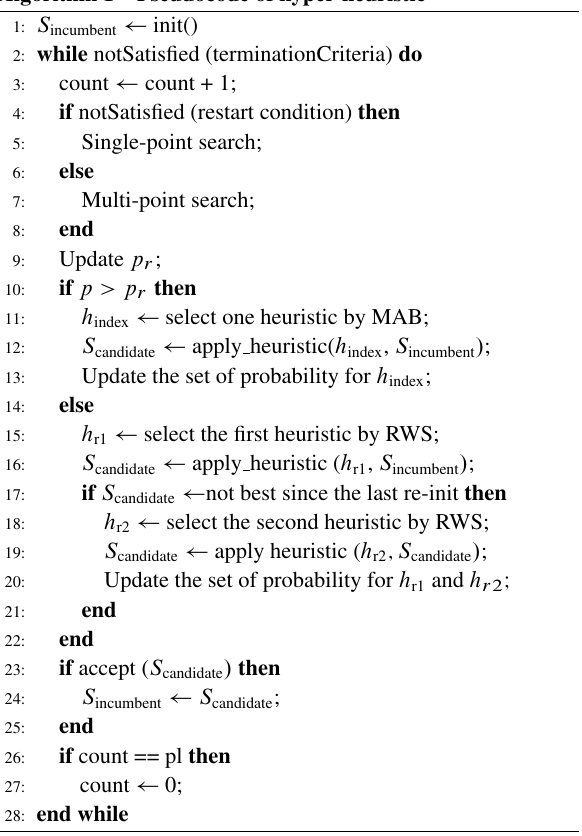
Algorithm 1 Pseudocode of